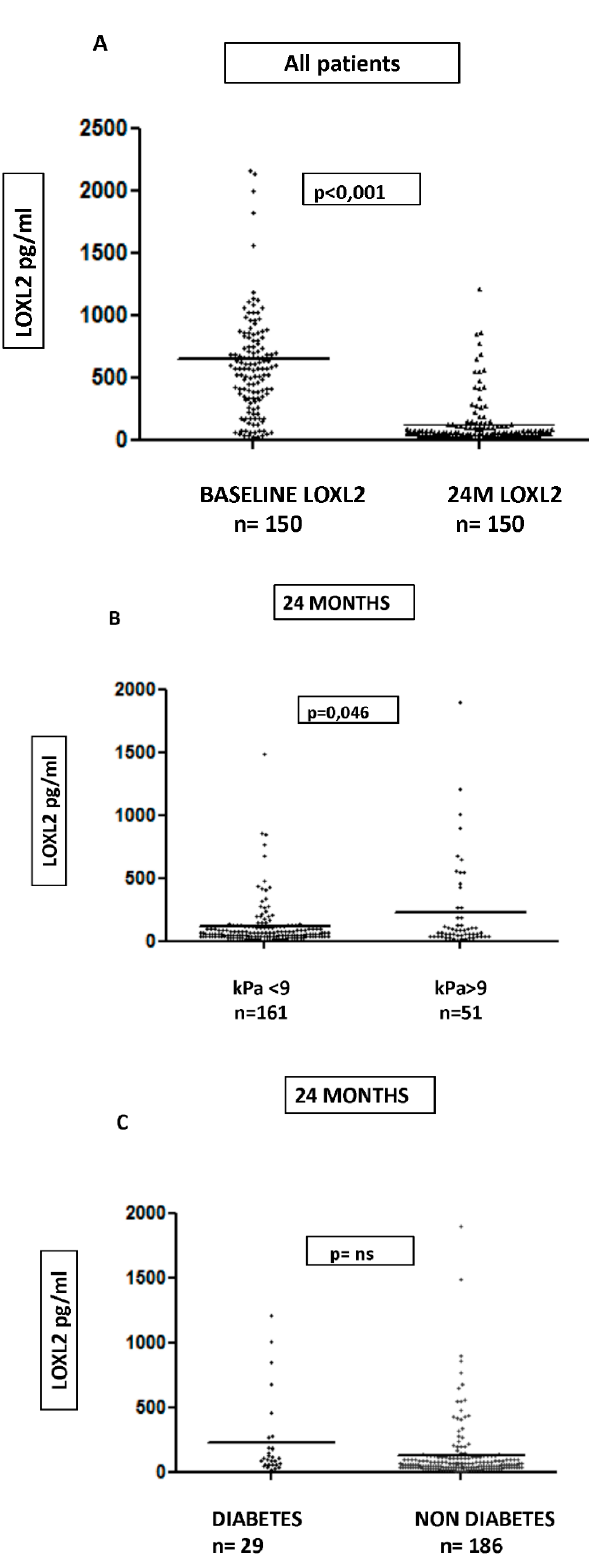
Figure 3. Di ff erences in serum LOXL2 concentration. A : n = 150, baseline at 891.80 ± 1616 pg / mL Figure 3. Differences in serum LOXL2 concentration. A: n = 150, baseline at 891.80 ± 1616 pg/mL vs. 24 vs. 24 M at 328.07 ± 1415.03 pg / mL; p < 0.001. B : n = 212; non-significant fibrosis (kPa < 9) at M at 328.07 ± 1415.03 pg/mL; p < 0.001. B: n = 212; non-significant fibrosis (kPa < 9) at 113.29 ± 176.96 113.29 ± 176.96 pg / mL vs. significant fibrosis (kPa > 9) at 216.63 ± 347.92 pg / mL, p = 0.046, at 24 months. pg/mL vs. significant fibrosis (kPa > 9) at 216.63 ± 347.92 pg/mL, p = 0.046, at 24 months. C: n = 215 C : n = 215 diabetic patients, 231.30 ± 310.28 pg / mL vs. nondiabetics, 127.05 ± 224.15, p = diabetic patients, 231.30 ± 310.28 pg/mL vs. nondiabetics, 127.05 ± 224.15, p = 0.09 .